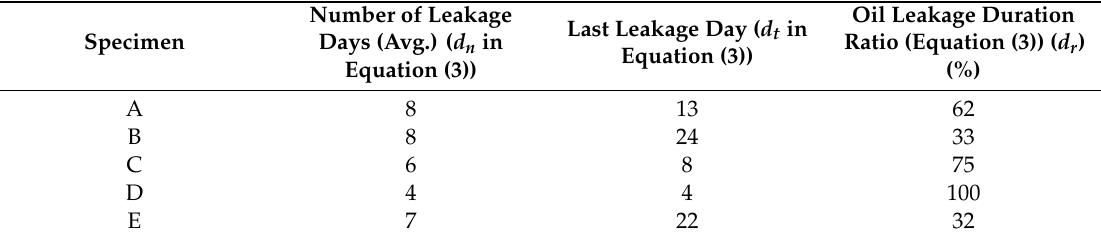
Table 17. Oil leakage duration ratio calculation results.